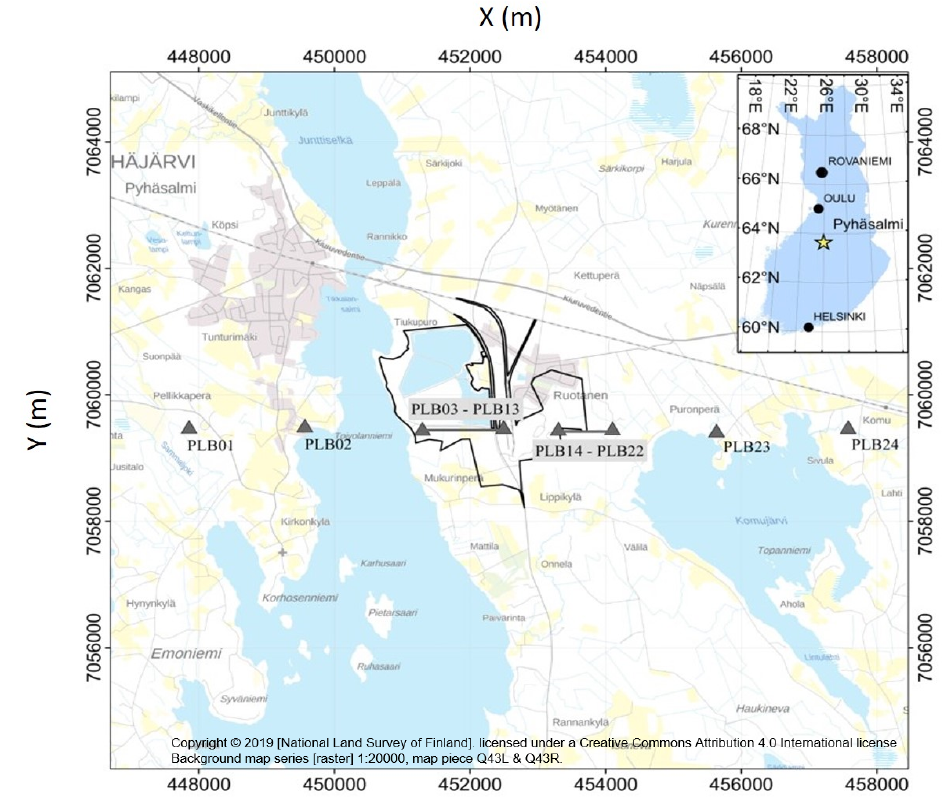
Figure 1. Map of the experiment near the Pyhäsalmi mine in Universal Transverse Mercator coordinate system with the two parts of the profile (PLB01-PLB13 – west part of profile; PLB14-PLB24 – east part of profile). Black lines are the borders of the mine and open-pit territories. At locations PLB01, PLB02, PLB03, PLB13, PLB14, PLB22, PLB23, and PLB24 both MEMS and Trillium Compact sensors were